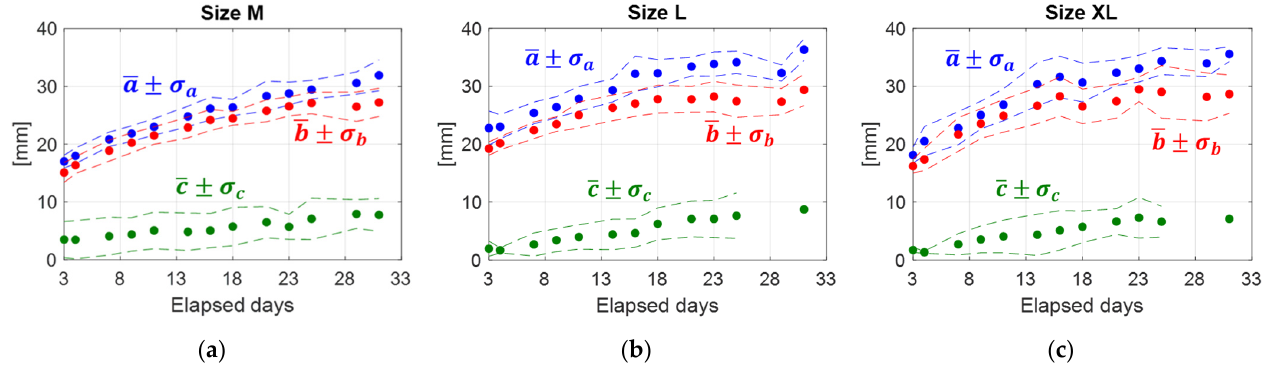
Figure 12. Estimation of the mean values (filled dots) of the geometrical parameters of the air chamber at elapsed days for egg of size M ( a ), size L ( b ) and size XL ( c ). a and b are the mean values of the minor and the major semi-axis of the air chamber on the front view, respectively, while c is the mean value of air chamber height on lateral view for each egg size category. σ a , σ b and σ c are the standard deviations of the previous defined quantities.